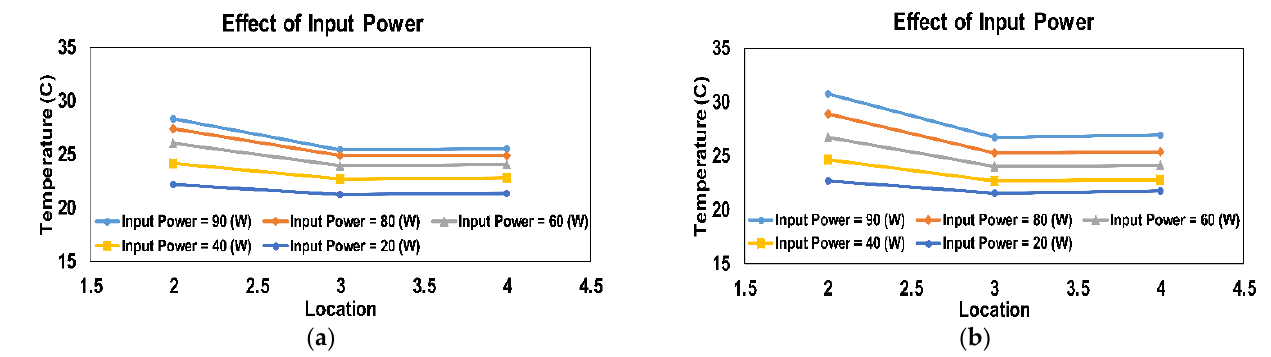
Figure 5. Effect of input power on the surface temperature of the RMDHL. ( a ) input amplitude 2.5 cm ( b ) input amplitude 3.9 cm.